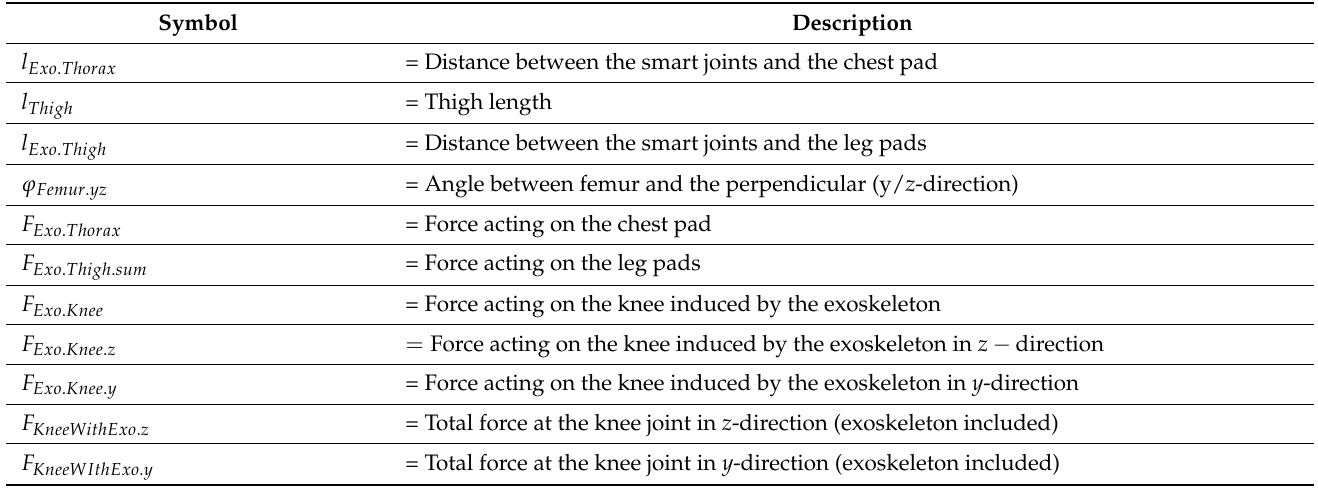
Table A4. Symbols with description and Equations as used for the model displayed in Figure